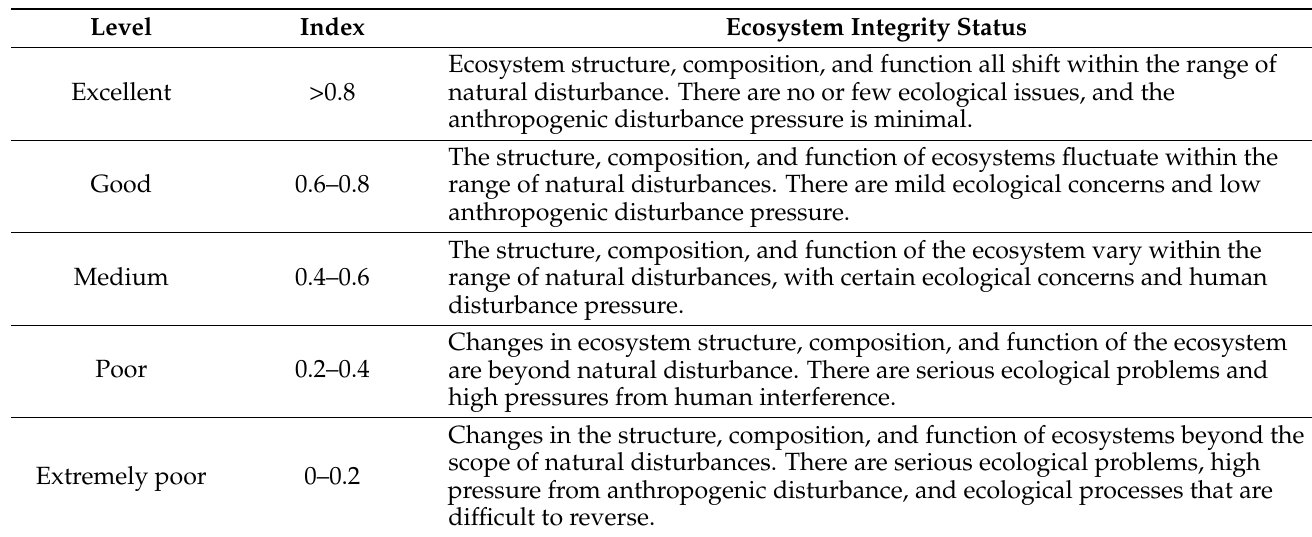
Table 7. Evaluation and grading of Ecosystem Integrity